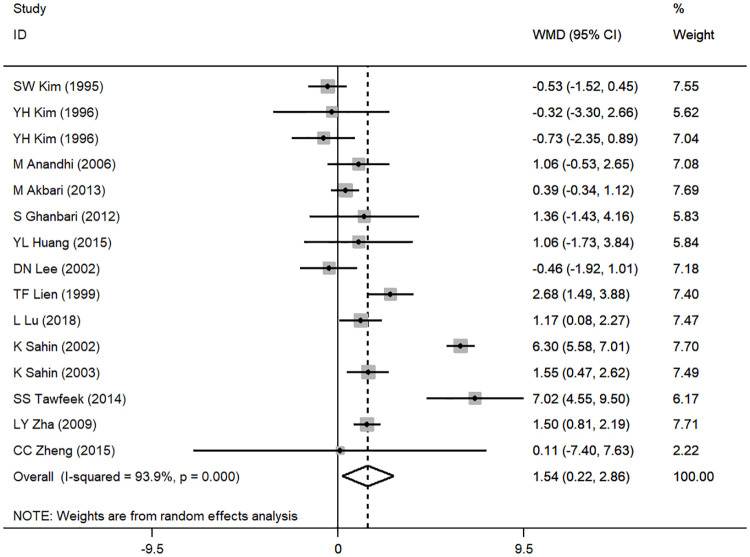
Forest plot of ADFI.